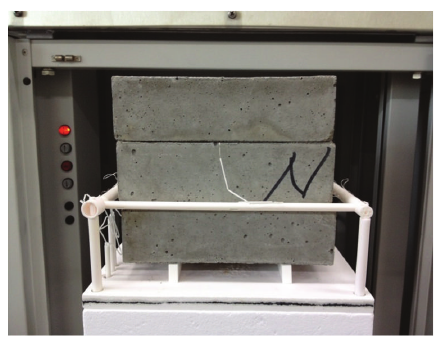
Figure 4: Thermal conductivity measurement of concrete bricks (230 mm × 114mm × 65 mm) using hot wire (platinum resistance thermometer technique)